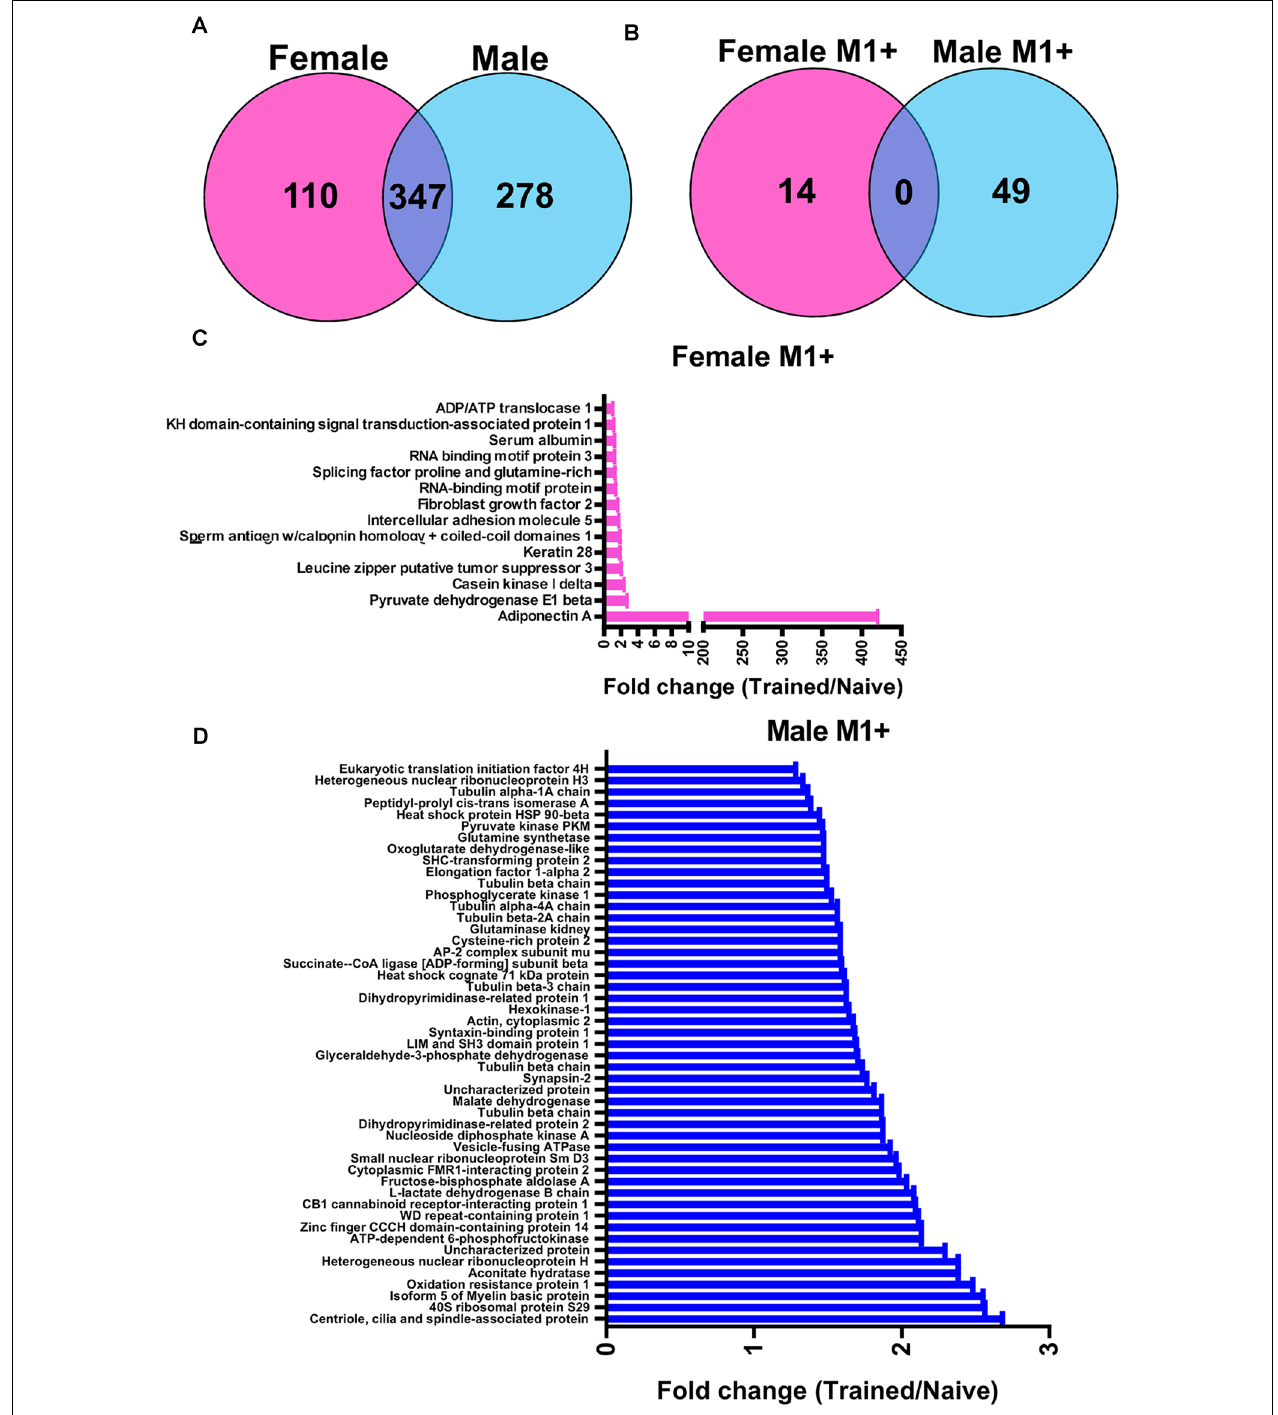
FIGURE 2 | Sex-specific protein targets of linear polyubiquitination in the amygdala following fear conditioning. Male and female rats were trained on a contextual fear conditioning paradigm and protein extracts from the BLA were collected 1 h later. Samples were then purified with a linear polyubiquitin-specific Tandem Ubiquitin Binding Entity (TUBE) and liquid chromatography mass spectrometry performed. These samples were compared with BLA tissue collected from naïve rats. (A) Venn diagrams showing the total number of identified linear polyubiquitinated proteins in female (pink) and male (blue) rats. (B) Venn diagrams showing the protein targets that gained linear polyubiquitination following fear conditioning in female (pink) and male (blue) rats. (C,D) Graph summarizing the protein targets that gained linear polyubiquitin modification following fear conditioning in female (C) and male (D) rats. Proteins are identified on the y -axis and fold change in linear polyubiquitination (Trained/Naïve) is on the x -axis. N = 5 per group per sex.